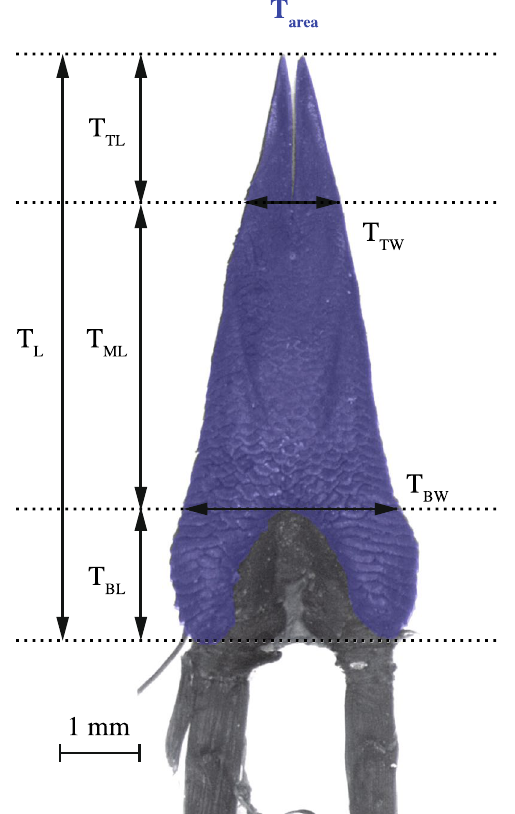
Figure 6. Photograph of a lacertid lizard’s tongue (dorsal view) with annotations on the morphological variables considered in this study. The surface area of the tongue is coloured. The tongue given for reference is from the species Acanthodactylus cantoris . Abbreviations: T BL = tongue base length; T BW = tongue base width; T ML = tongue mid length; T TL = tongue tip length; T TW = tongue tip width; T L = tongue length; T area = tongue surface